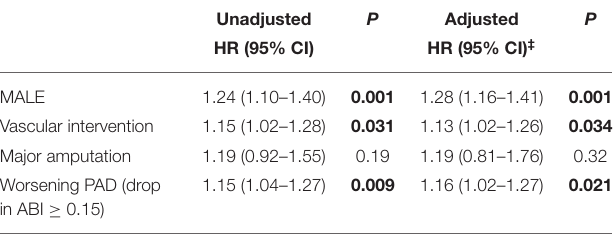
TABLE 3 | Hazard ratios for events per one unit increase in uFABP3/uCr.